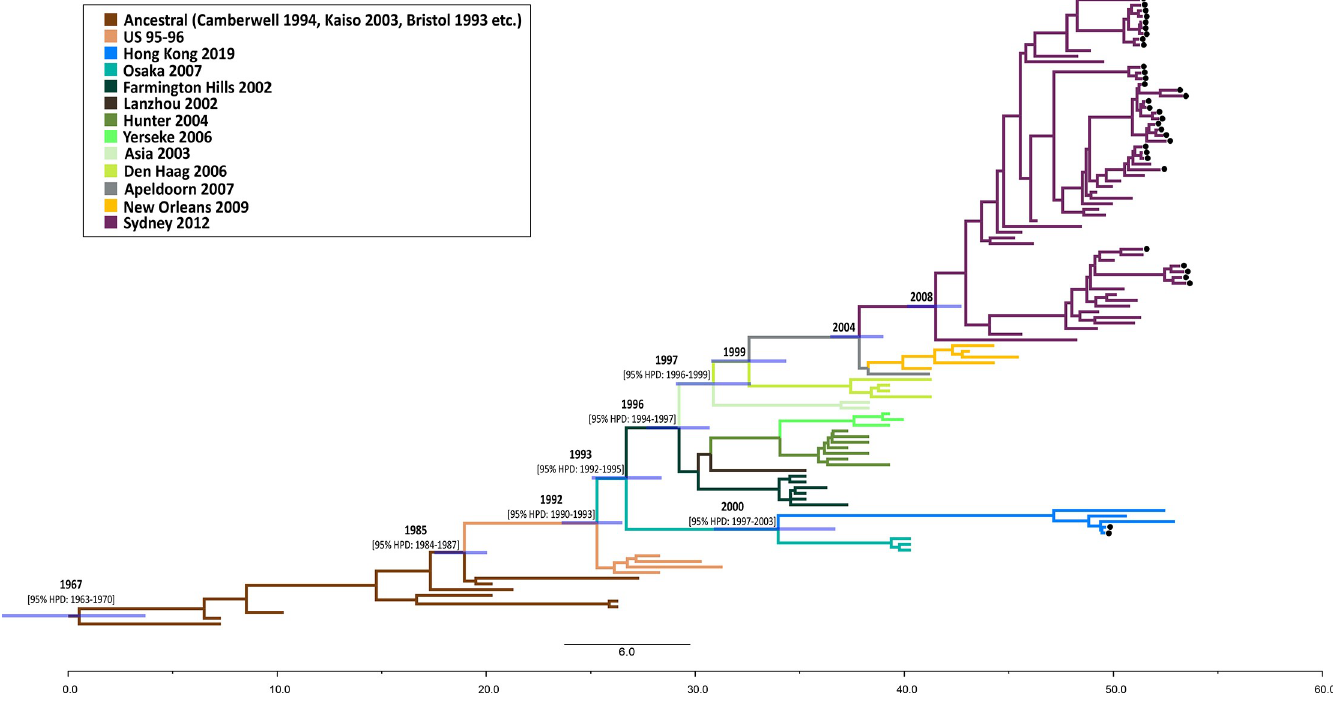
Fig 2. Bayesian time-scale phylogenetic analysis of norovirus GII.4 variants based on their complete VP1 sequences (n = 111). The 34 Thai GII.4 strains from this study including two Thai GII.4 Hong Kong (denote by dots) and the color-coded reference strains reported over the past 50 years are shown. The maximum clade credibility tree was constructed using the TreeAnnotator/FigTree. Bars at the branch nodes denote 95% highest posterior density intervals for the estimated year of divergence (bolded). Time scale is shown at the bottom of the tree (reference length represents 6 years).